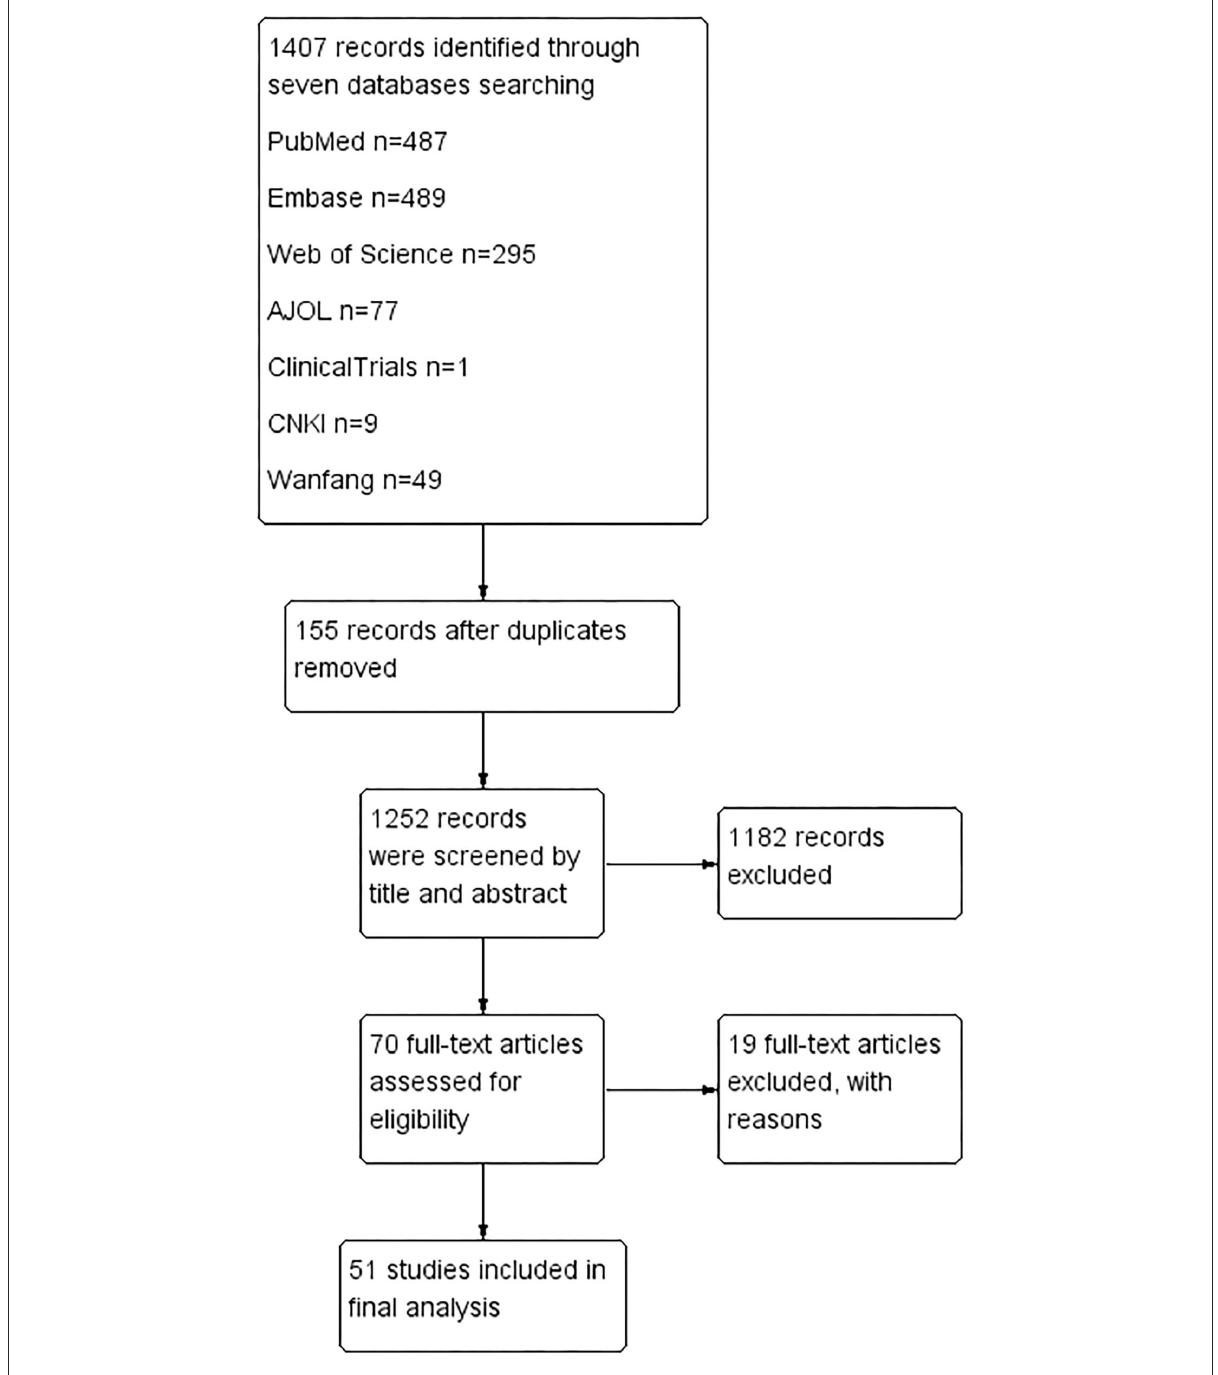
FIGURE1 PRISMA flow diagram for study selection